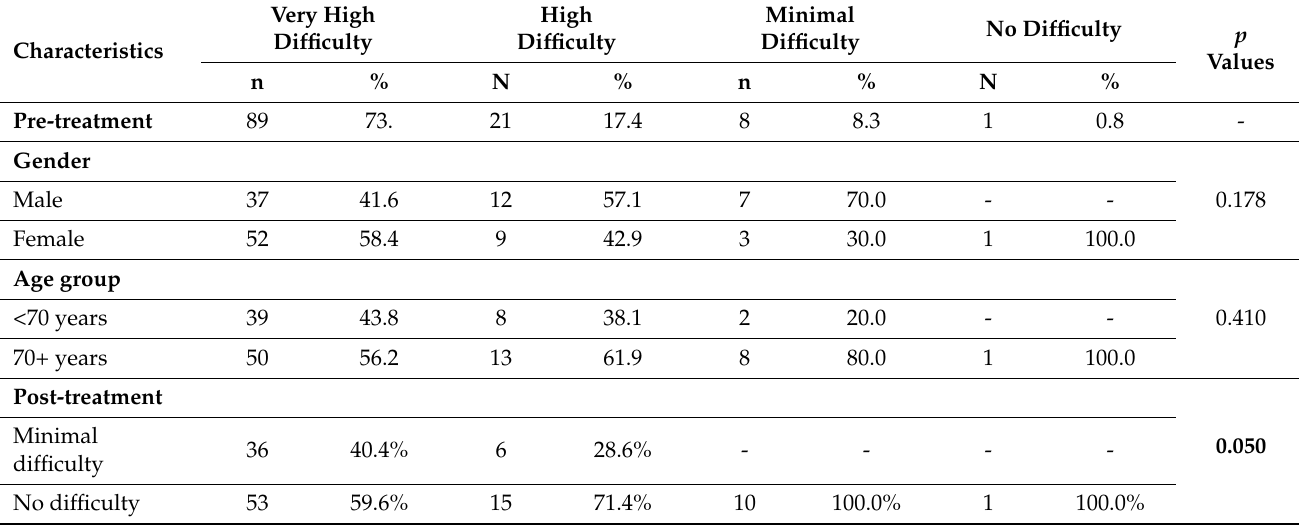
Table 4. The percentage distribution of patients with reading difficulties reading prices according to pre- and post-treatment study group